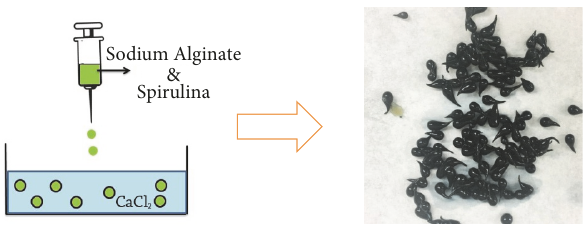
Figure 1: Bead formation using the external gelation